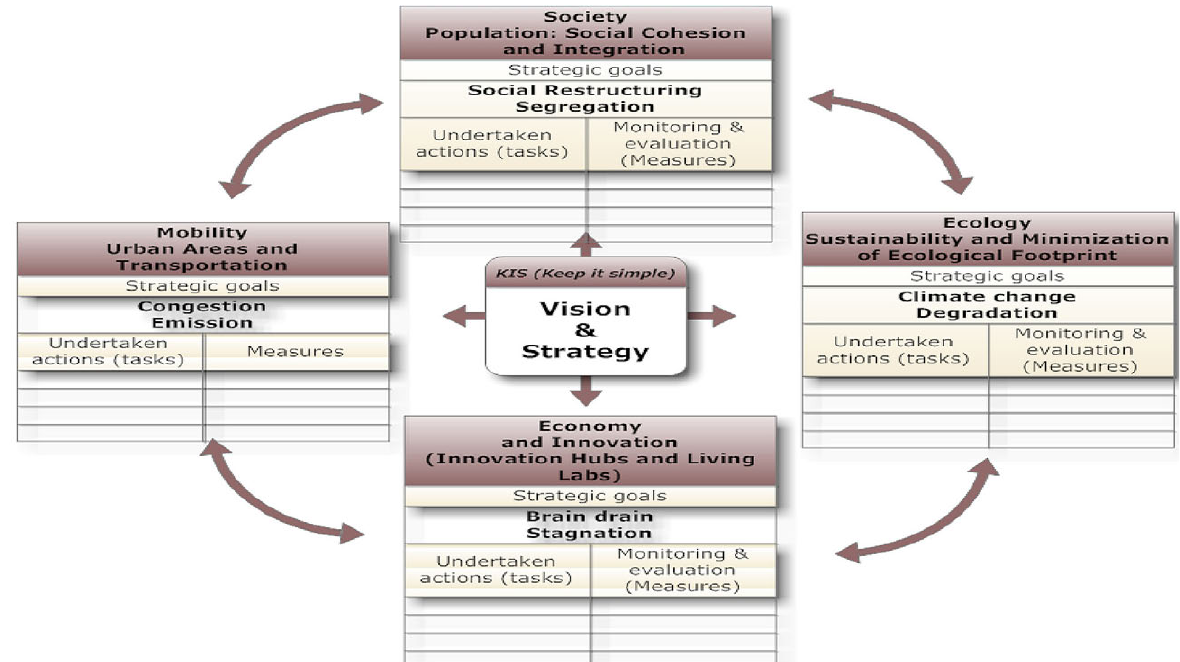
Fig. 6. P. Nijkmap’s view on a smart, interactive navigation tool based on a balanced trade-off of Society, Environment and